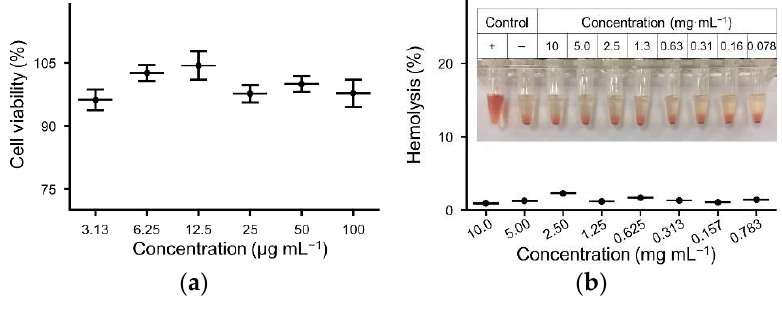
Figure 5. Biological compatibility of mPEG 45 −PLAla 30 . ( a ) In vitro cytotoxicity of the mPEG 45 −PLAla 30 toward L929 cells. Data were presented as mean ± SD ( n = 5); ( b ) Hemolysis experiments of mPEG 45 −PLAla 30 . Data are presented as mean ± SD ( n = 3).